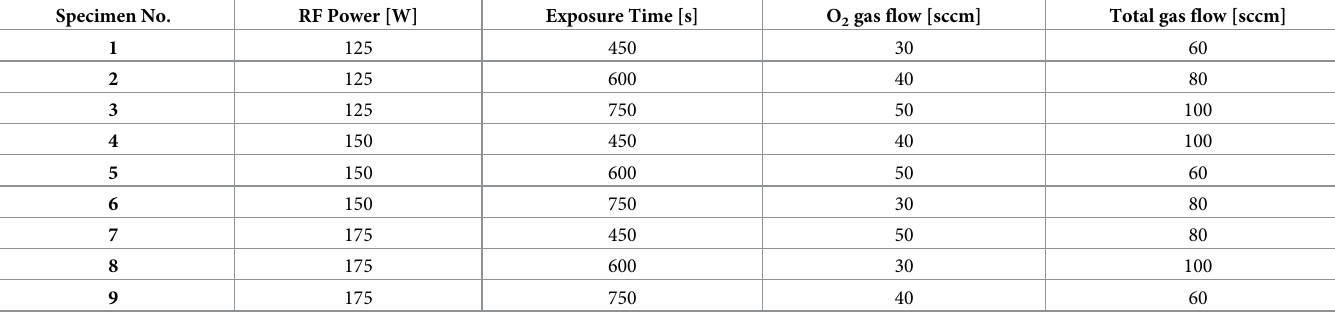
Table 1. Design of surface treatment parameters for plasma treatment. Specimen